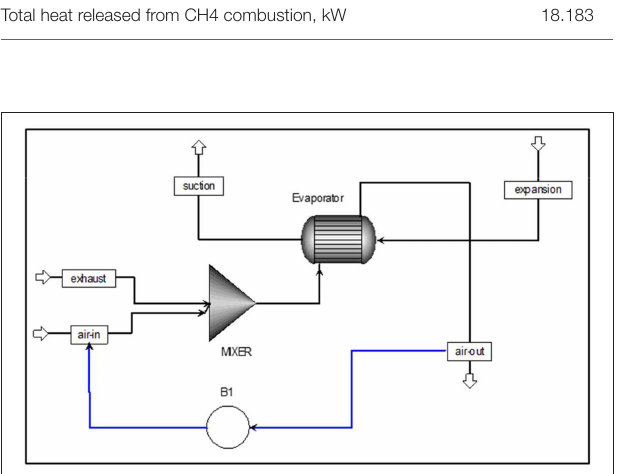
FIGURE 8 | Schematic diagram of the dynamic model for control strategy